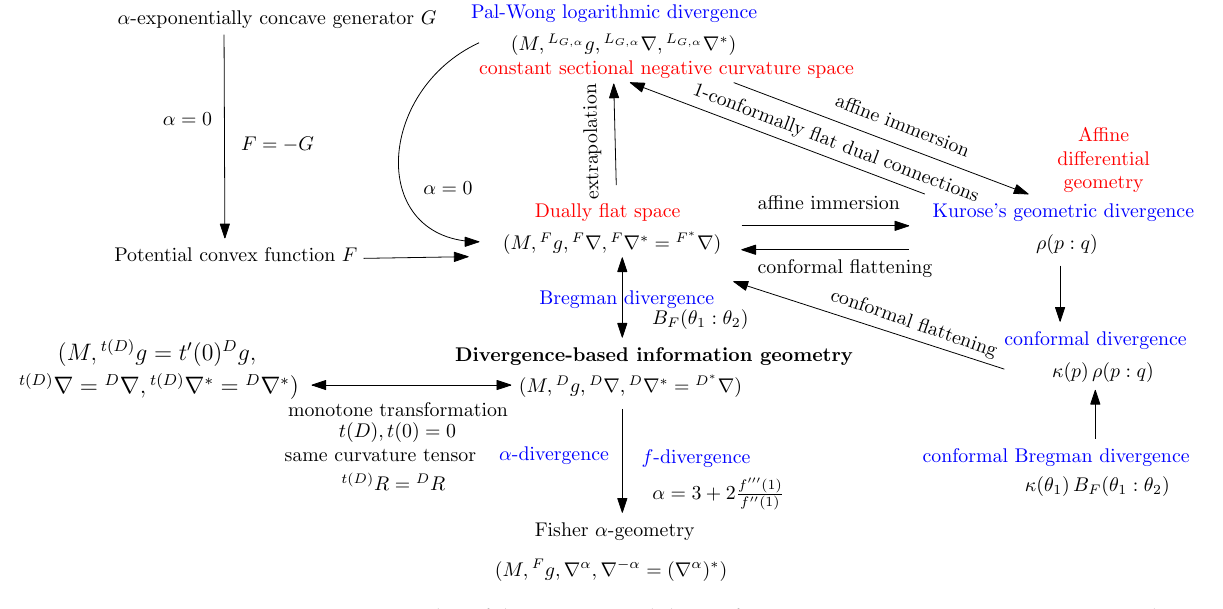
Figure 1. Interplay of divergences and their information-geometric structures: Bregman divergences are canonical divergences of dually flat structures, and the α -logarithmic divergences are canonical divergences of 1-conformally flat statistical manifolds. When α → 0, the logarithmic divergence L F , α tends to the Bregman divergence B F .